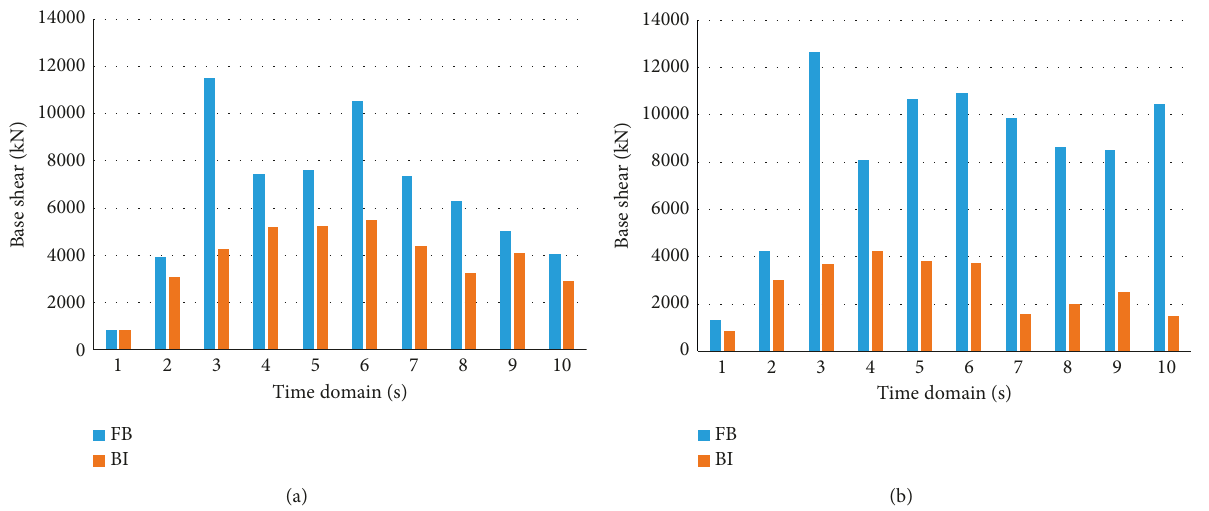
Figure 14: Absolute base shear reduction in FBI adjacent buildings. (a) Longitudinal direction. (b) Transverse direction.